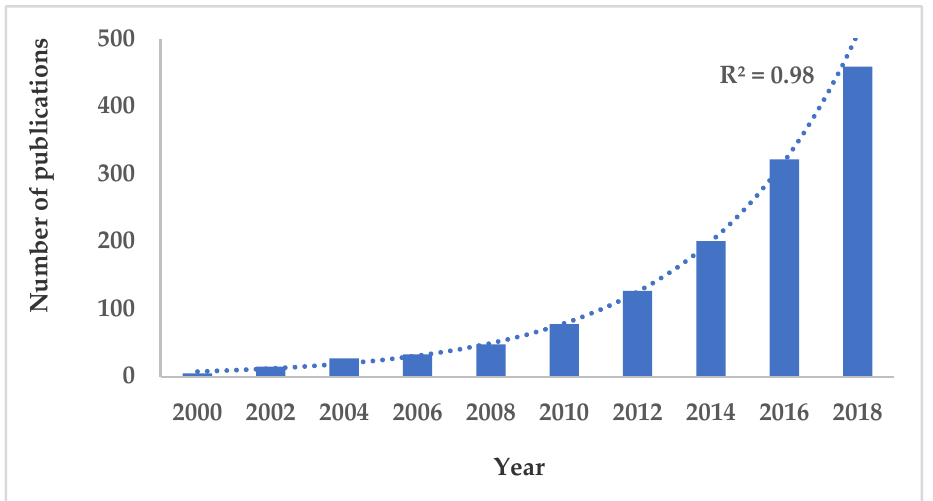
Figure 1. Cumulative number of studies investigating the impact of thermal treatments on fish and meat using spectroscopic techniques since the year 2000. Information obtained from the database Scopus (Search criteria: All fields: Thermal treatments, AND Article title, Abstract, Keywords: Spectroscopy, AND Article title, Abstract, Keywords: ‘‘Fish AND/OR Meat). The data were obtained on 22 May